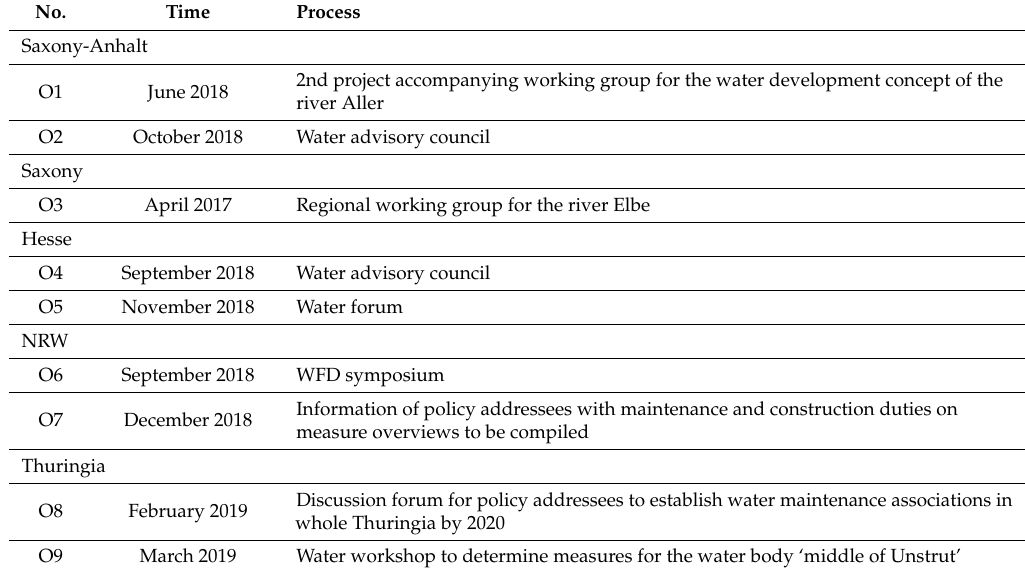
Table A6. Participatory